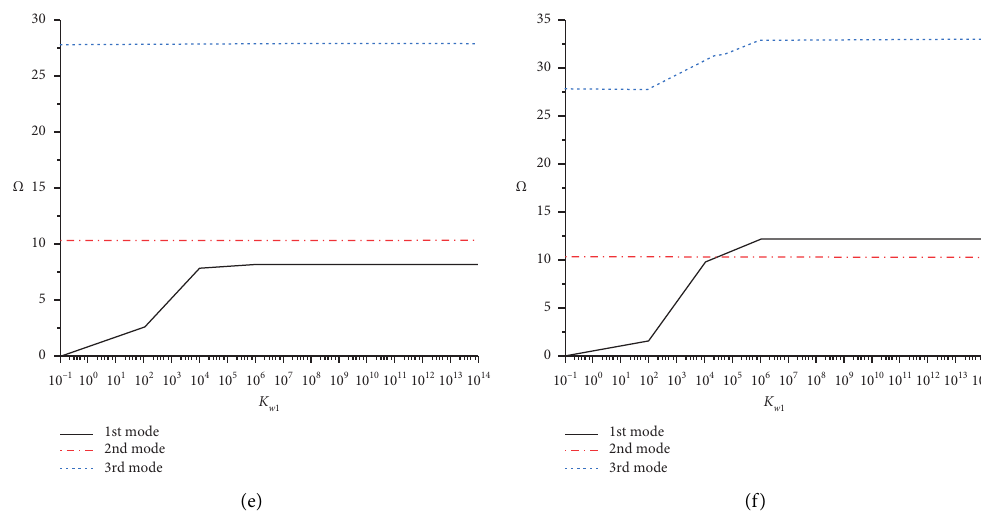
Figure 4: The influence of spring parameter on the first three-order dimensionless natural frequencies of the curved beam. (a) Spring k (b) Spring k w . (c) Spring K w . (d) Spring k v . (e) Spring K u 1 . (f) Spring K v 1 1 1